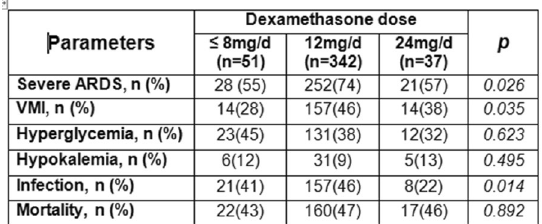
Table 1: outcome comparison according to dexamethasone